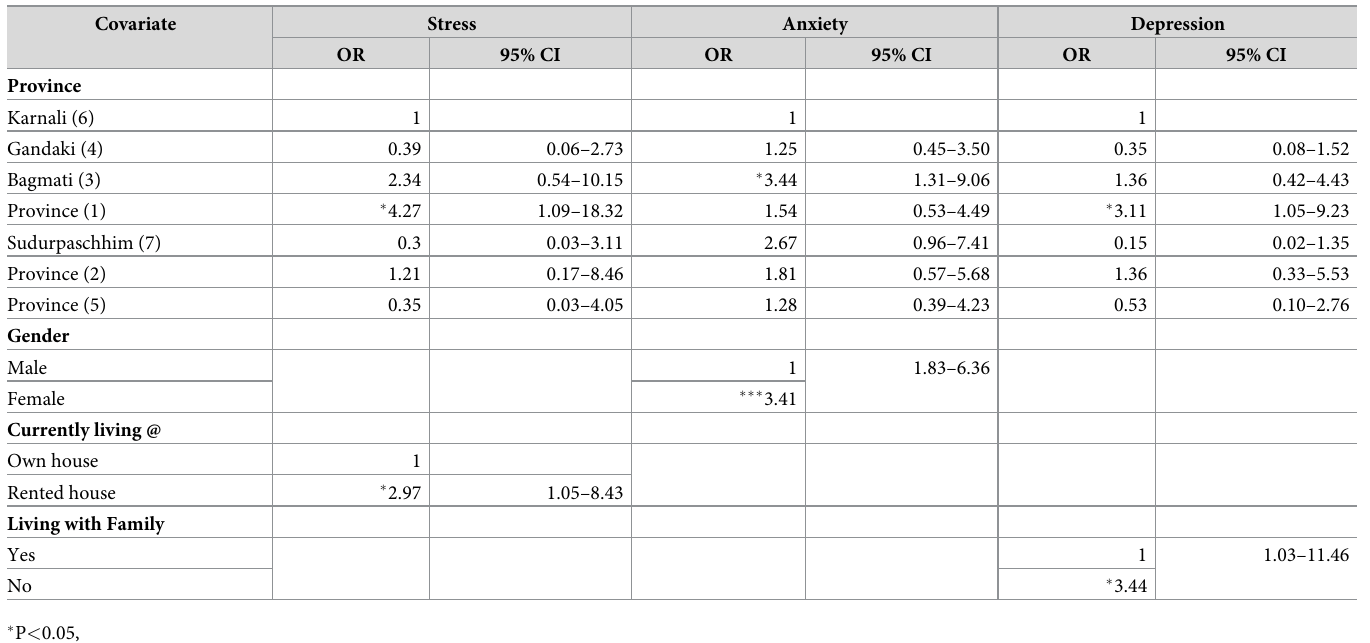
Table 5. Multivariate analysis of stress, anxiety and depression by selected